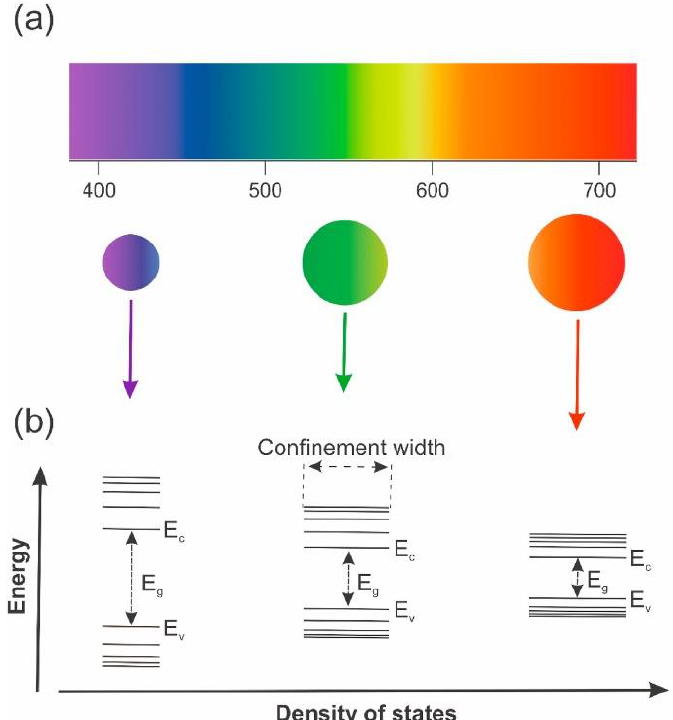
Figure 4. Schematic of ( a ) emission spectra QDs with different sizes; ( b ) the QDs size effect on their bandgaps [33].